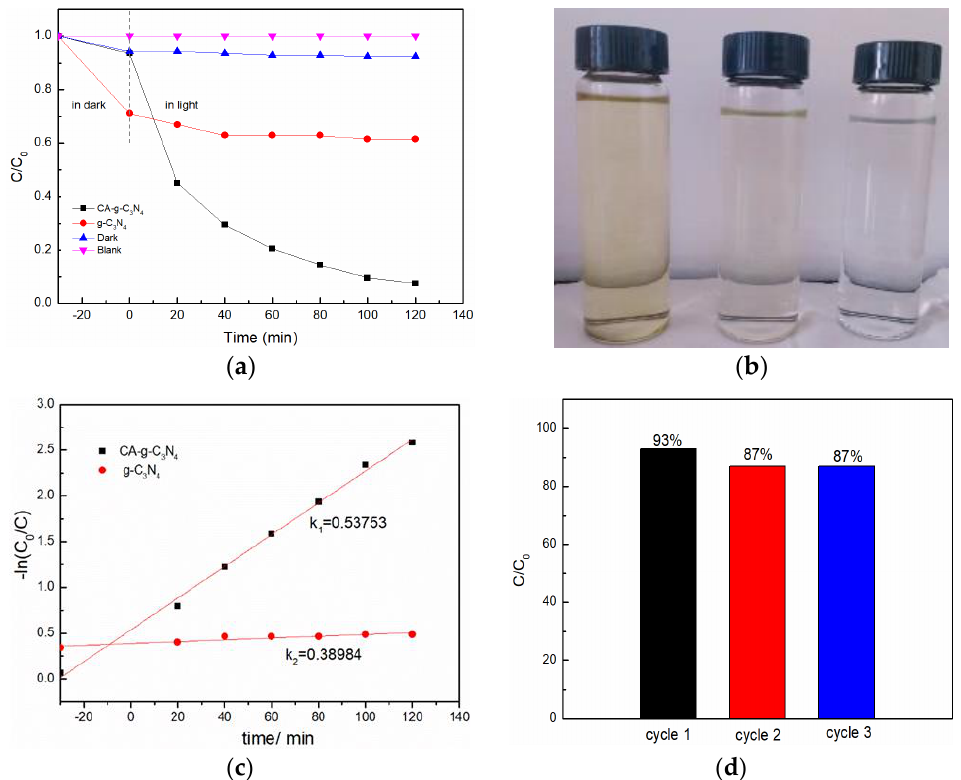
Figure 5. Removal rate of g-C 3 N 4 and CA-g-C 3 N 4 on Cr( Ⅵ ) ( a ), the color changes before and after the reaction ( b ), the kinetic constant k of different samples ( c ), the cyclic removal curve of CA-g-C 3 N 4 ( d ). Table 2. The double beam UV-visible spectrophotometer for before and after removal of chromium (VI).